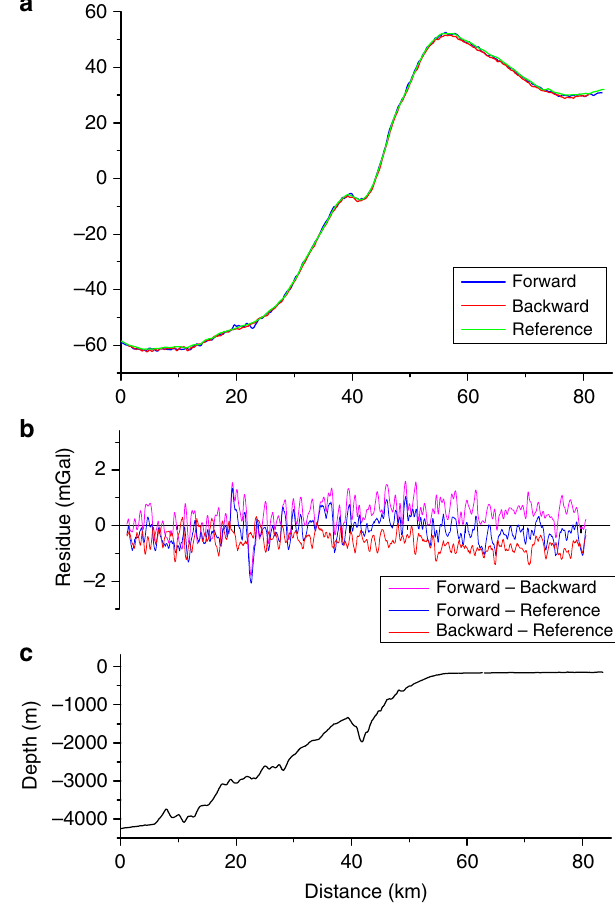
Fig. 4 Absolute gravity measurements along the calibration pro fi le. a Free air gravity anomaly measured by the atom gravimeter (forward and backward) and free gravity anomaly from Shom reference data. b